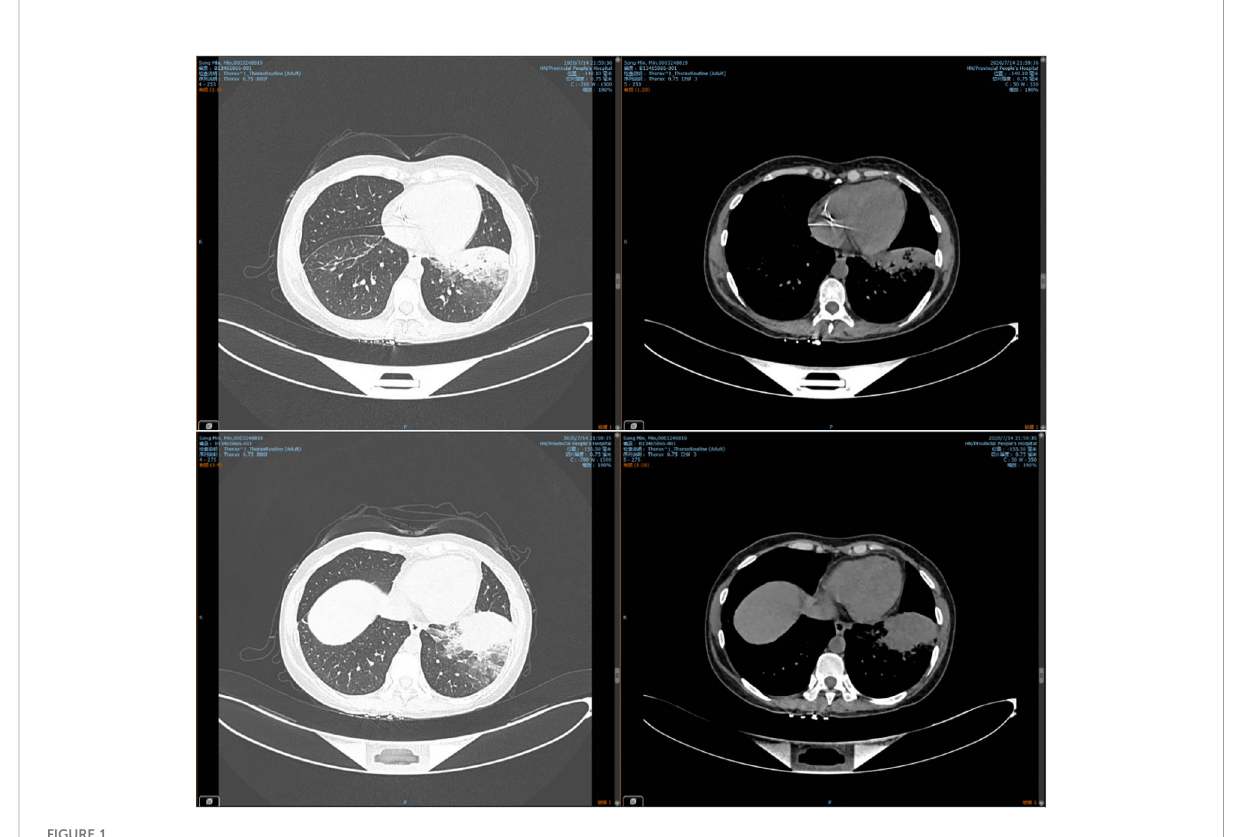
FIGURE 1 Chest CT on July 14, 2020, showing consolidation in the left lower lung.